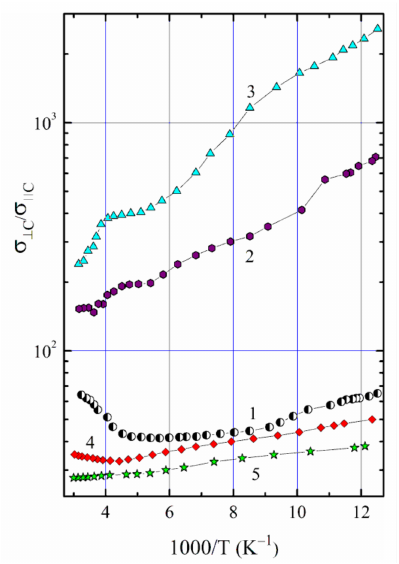
Figure 6. Temperature dependences of the conductivity anisotropy for the n -InSe samples: pristine (1), first-time and repeatedly intercalated with RbNO 3 (2 and 3, respectively), and annealed in vacuum (4 and 5,